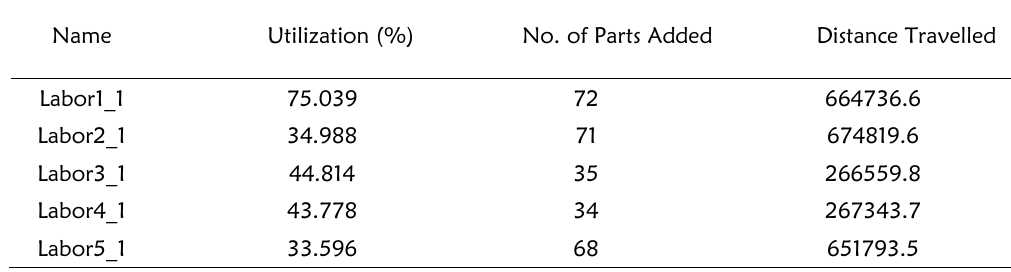
Table 2: Utilization, parts transferred, and distance travelled for the manual system